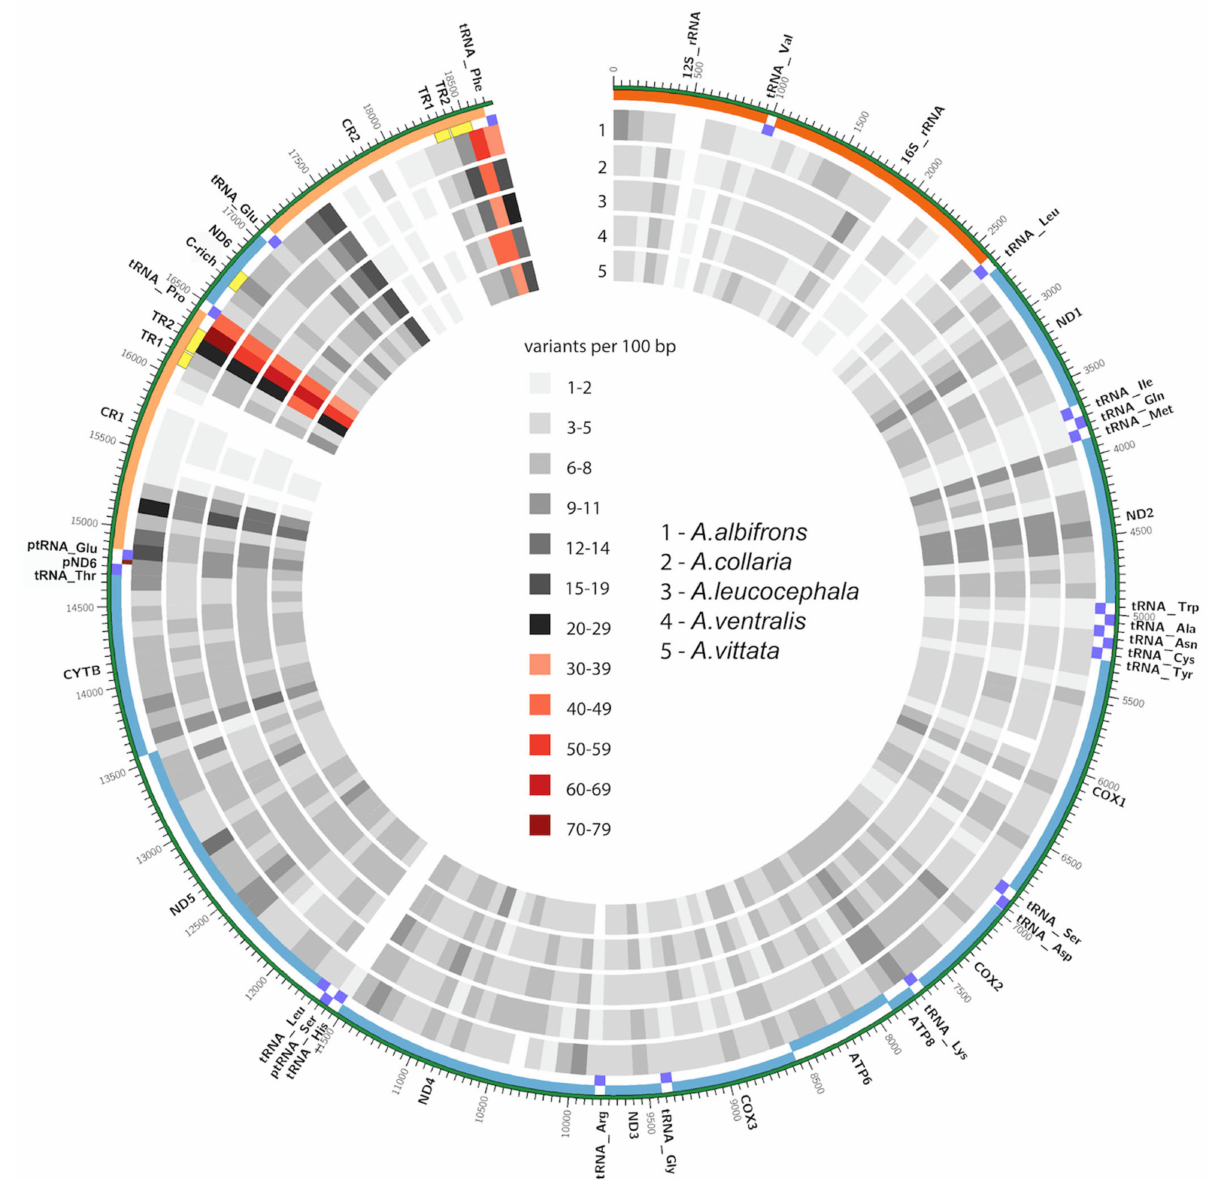
Figure 3. Mitogenome assemblies of the five species of Amazona from the Greater Antilles compared to the black-billed parrot ( Amazona agilis ) from Jamaica showing the density of variants. Consensus sequences were used if more than one individual was available for the species. The outer track shows the features from the mitogenome annotation. The diversity tracks (01–05) show variant density (per 100 bp) of the pairwise differences between A. agilis and (from the outside in): (1) white-fronted parrot (A. albifrons ), yellow-billed parrot ( A. collaria ), Cuban Parrot ( A. leucocephala ), Hispaniolan Parrot ( A. ventralis ), and the Puerto Rican parrot ( A. vittata ). Pairwise absolute character differences among five species of Greater Antillean Amazona parrots based on alignment to A. agilis are given in Supplementary Table S8. The figure was generated using Circos